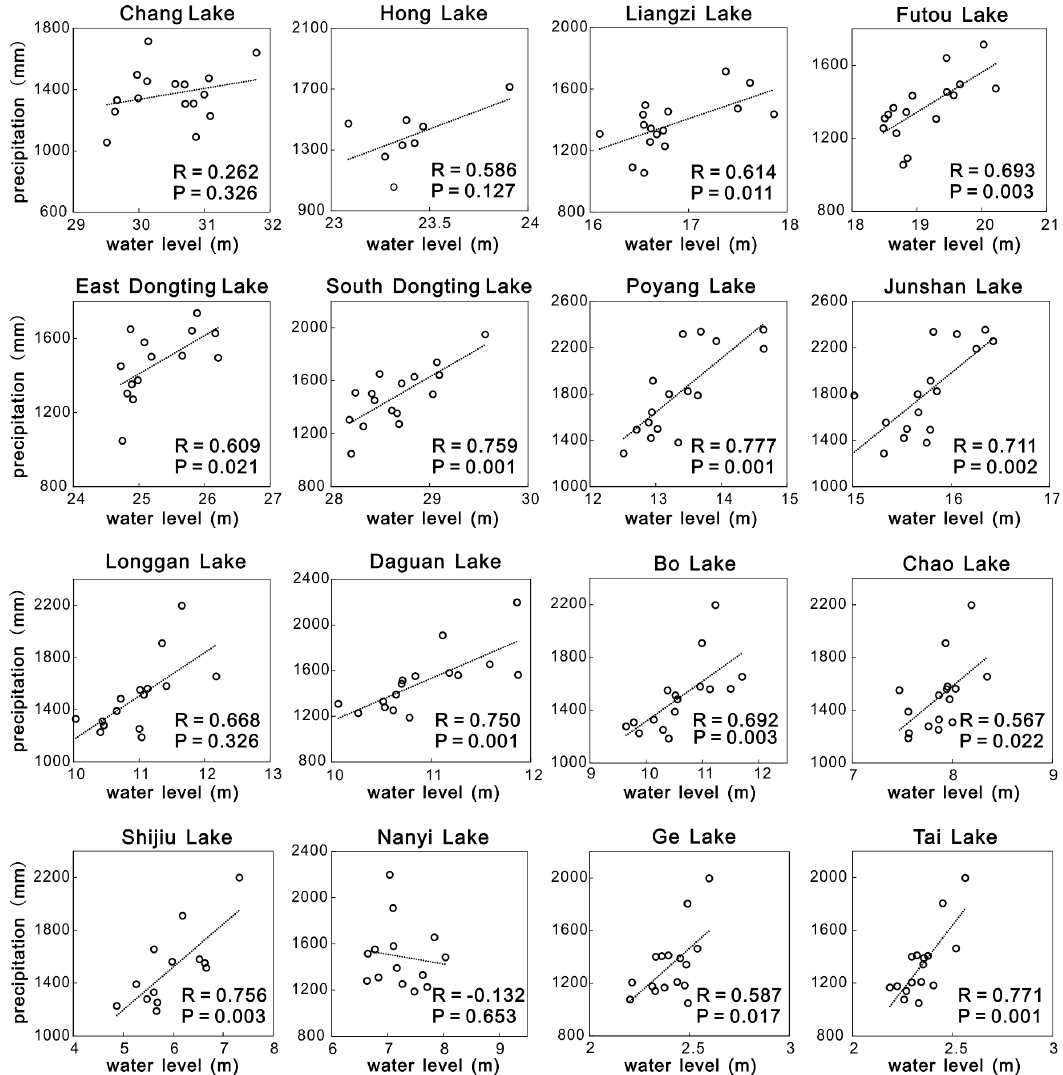
Figure 10. Correlation between annual mean water level and the corresponding annual precipitation of 16 large lakes in the MLYB.